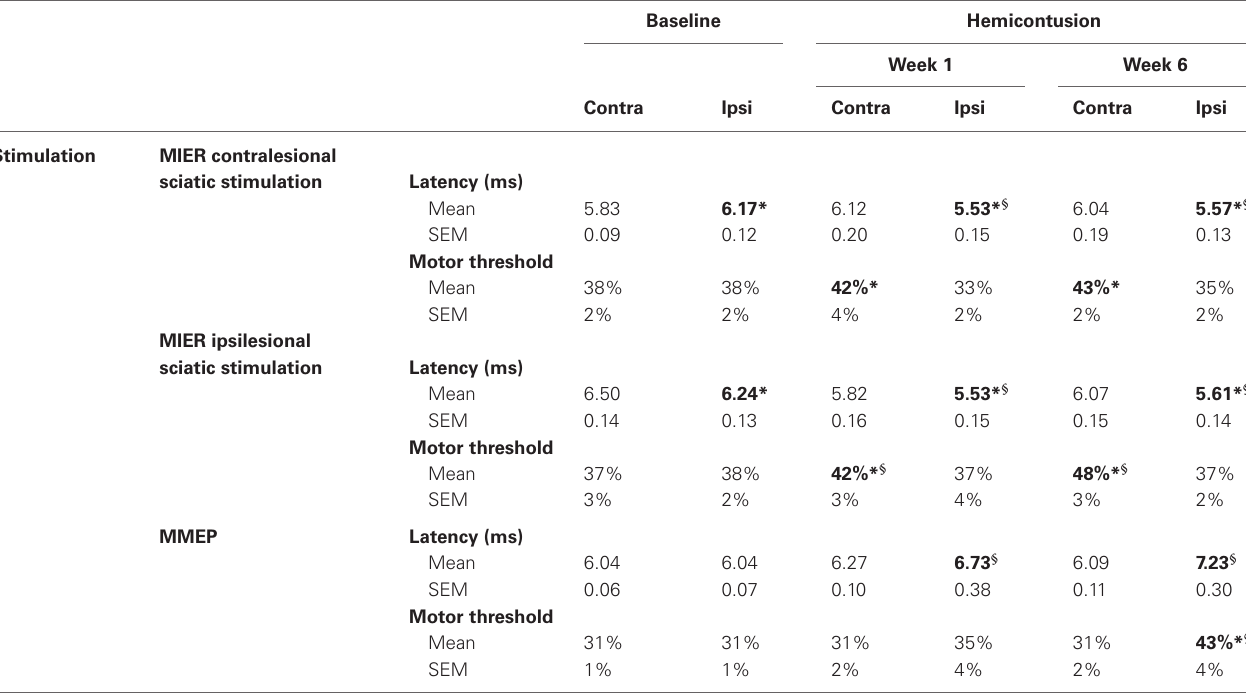
Table 2 | Magnetic inter-enlargement responses and motor-evoked potentials latency and motor threshold 1 week and 6 weeks after